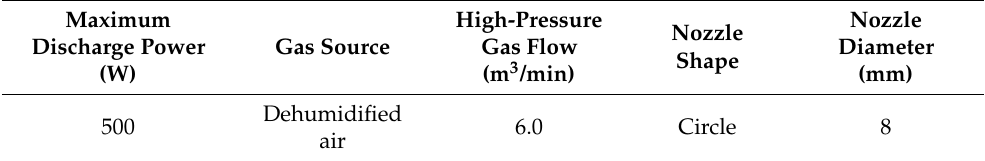
Table 4. Technological parameters of ion treatment.